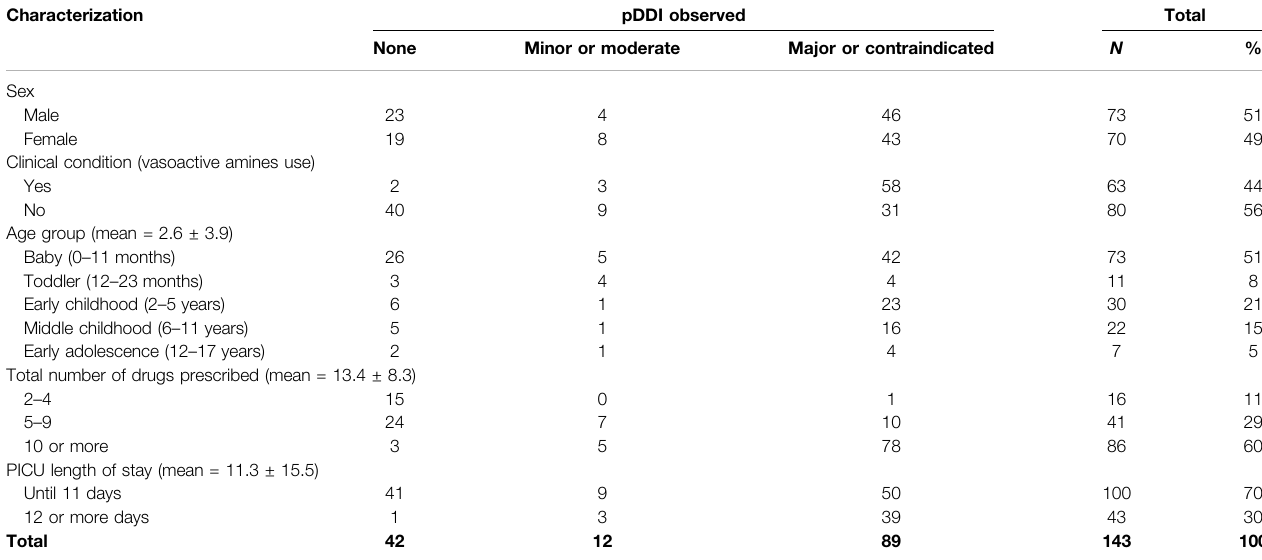
TABLE 1 | Children ’ s pro fi le distribution by the most severe pDDI observed (Teaching Hospital PICU, Rio de Janeiro, Brazil).